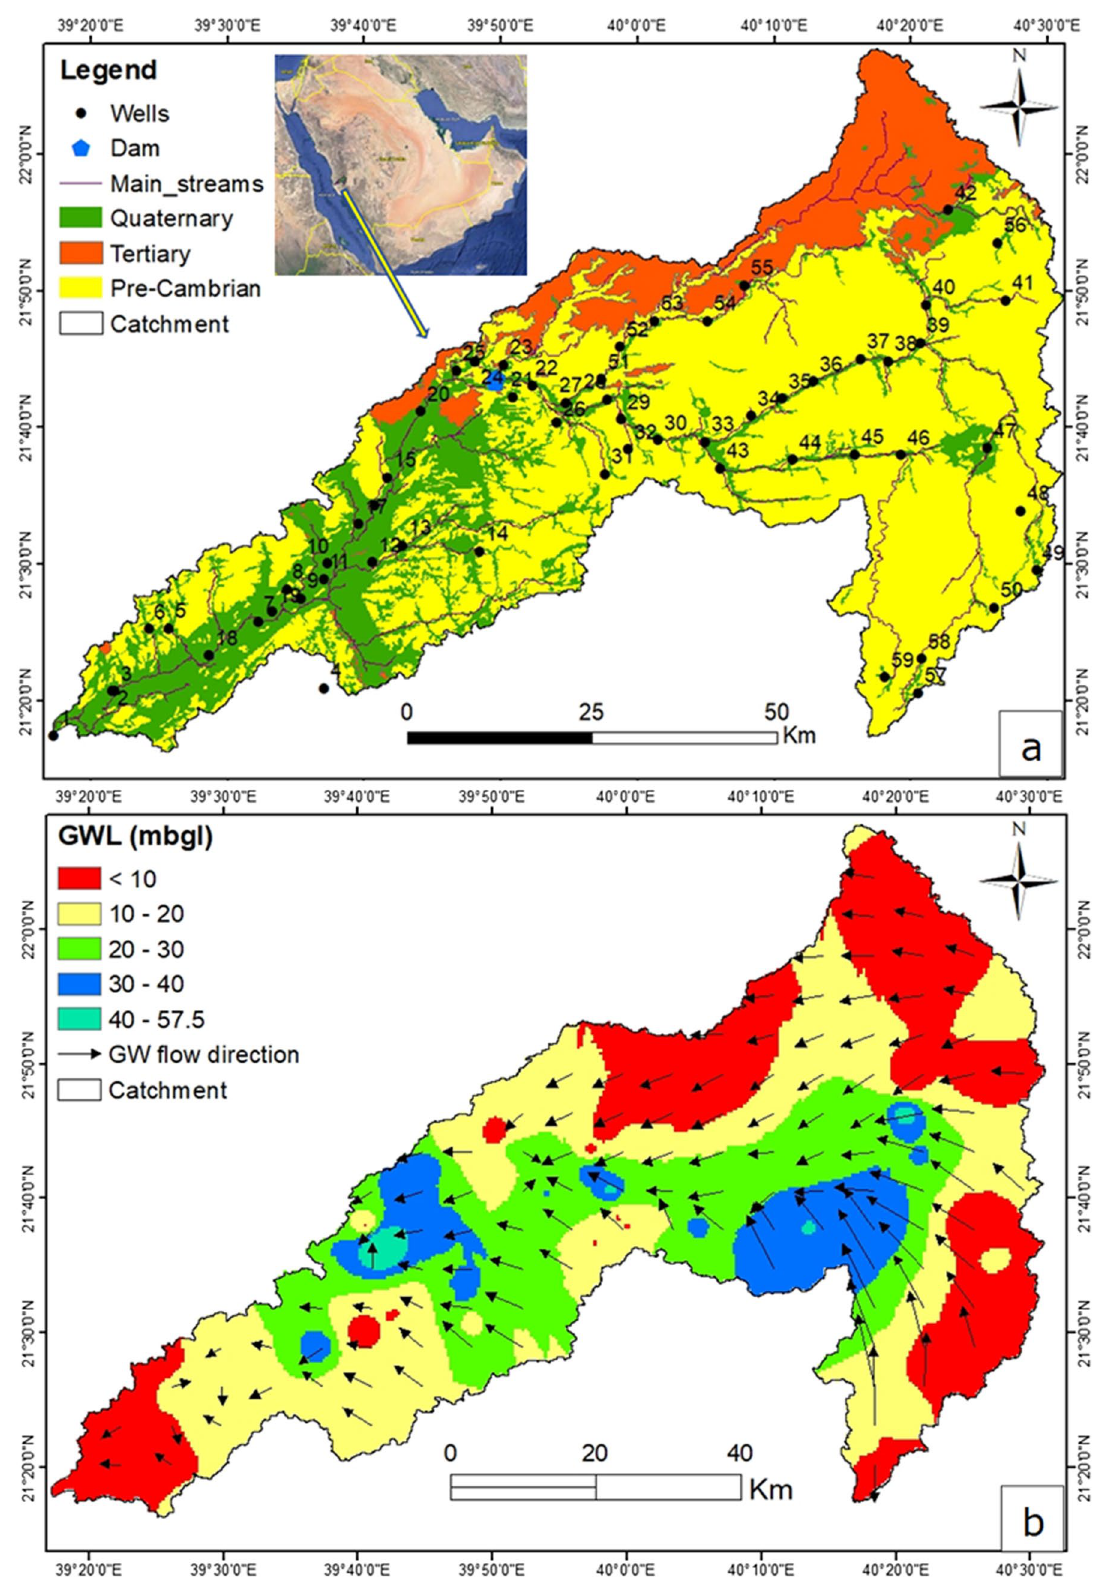
Fig. 1 Sampled wells location, geology and drainage pattern ( a ) and depth to groundwater level and groundwater flow direction ( b ) in the Wadi Fatimah